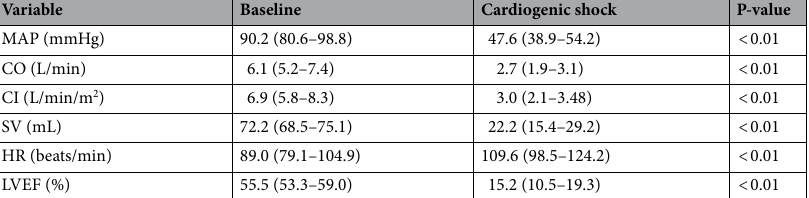
Table 1. Major hemodynamic variables at baseline and after the development of cardiogenic shock. Data presented as median (interquartile range) unless otherwise indicated. CO cardiac output, HR heart rate, LVEF left ventricular ejection fraction, MAP mean arterial pressure, SV stroke